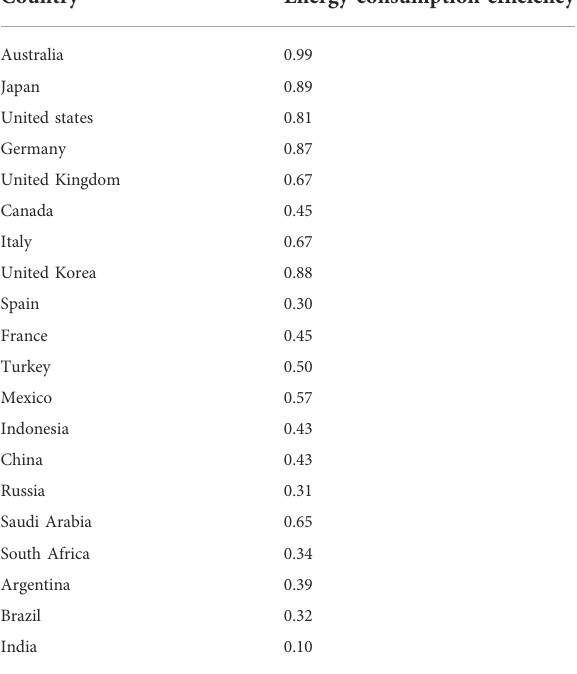
TABLE 2 Primary Energy Consumption ef fi ciency.